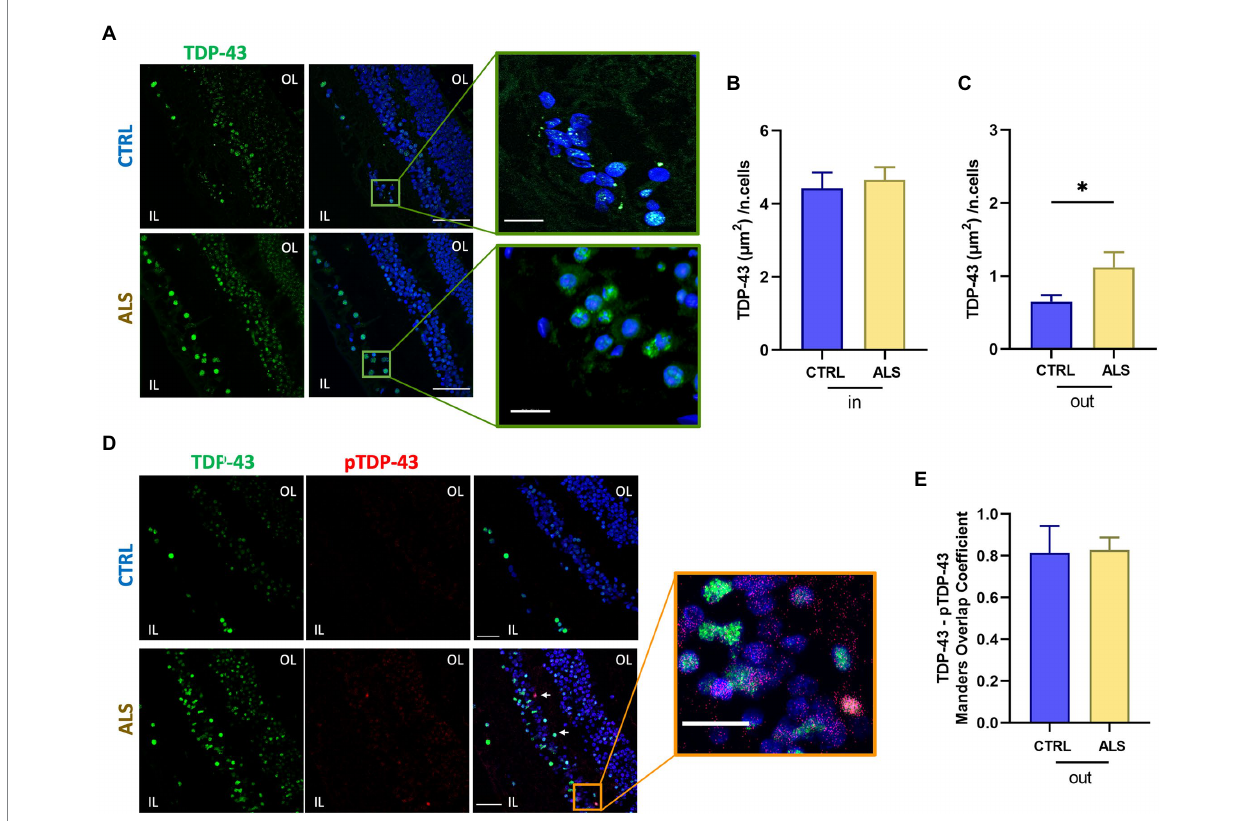
FIGURE 1 TDP-43 inclusions are mislocalized in the human amyotrophic lateral sclerosis (ALS) retina. (A) Representative images of retinal slices from ALS patients and healthy controls immunolabeled with anti-TDP-43 (green) and Hoechst for nuclei visualization (blue); scalebar 50 μ m. Zoom: Imaris 3D reconstruction of TDP-43 staining in the ALS retina at higher magnification showing TDP-43 staining outside the nucleus; bar 10 μ m. (B) Bar chart showing the quantification of the area covered by TDP-43 signal inside the nucleus (in) normalized by the number of cells (ALS n = 57/7 fields/ individuals; CTRL n = 50/6 fields/individuals). (C) Bar chart showing the quantification of the area covered by TDP-43 signal outside the nucleus (out) normalized by the number of cells ( * p < 0.05 ALS vs. CTRL, Mann–Whitney U test; ALS n = 57/7 fields/individuals; CTRL n = 50/6 fields/individuals). (D) Representative immunostaining of anti-TDP-43 (green), anti-pTDP-43 (red), and Hoechst for nuclei visualization (blue) in ALS and control retinal slices; scale bar 50 μ m. Arrows indicate co-localized signals. Zoom: Co-localization of TDP-43 and pTDP-43 in the ALS retinal slice; scalebar 20 μ m. IL, inner layer; OL, outer layer. (E) Bar chart displaying the Manders Overlap coefficient of pTDP-43 and TDP-43 signals in the cytoplasmic region. Note that the amount of cytoplasmic TDP-43 is significantly higher in ALS patients (C)